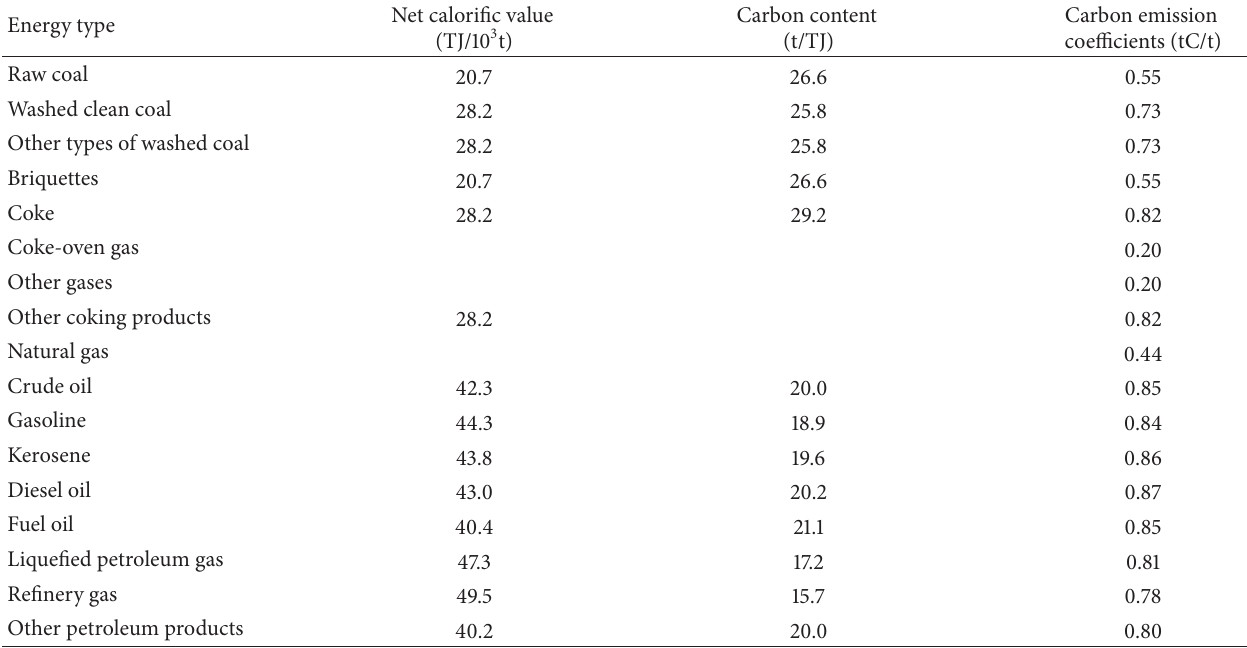
Table 1: Carbon emission coefficients of different kinds of energy.